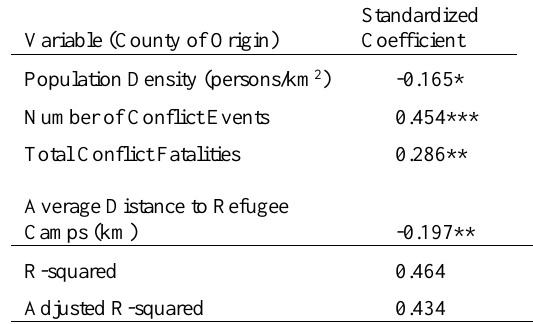
Table 2. Ordinary Least Squared Regression Results Predicting Refugee Rates from South Sudan Counties (n = 78) to Uganda